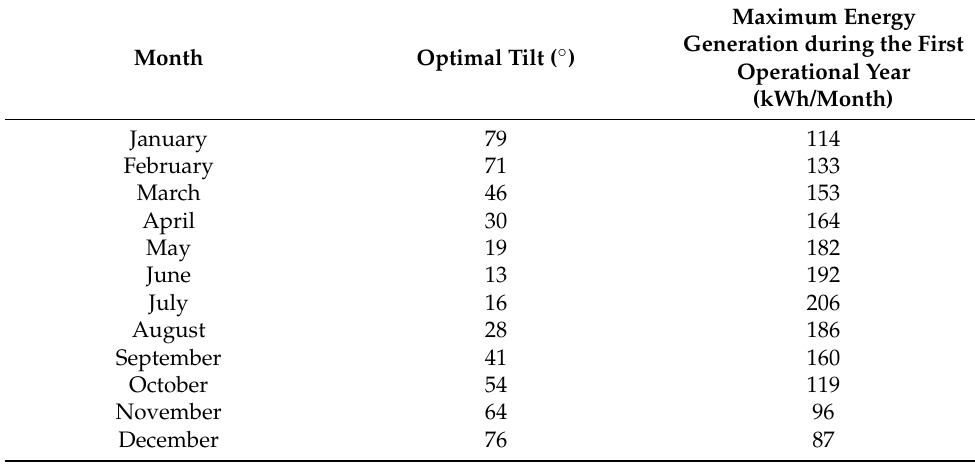
Table 6. Monthly optimal tilt angles in London, Ontario.